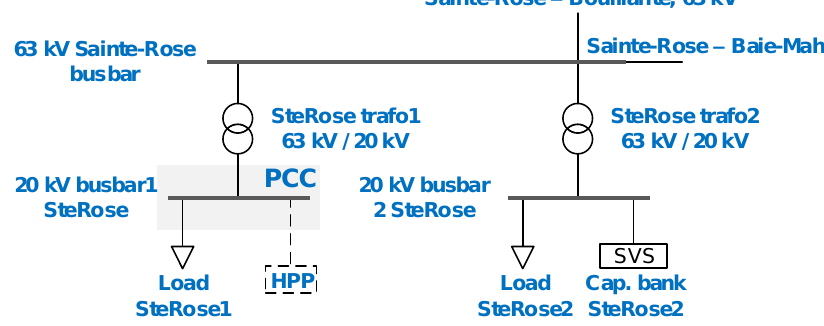
Figure 4. Sainte-Rose substation in Guadeloupe electrical